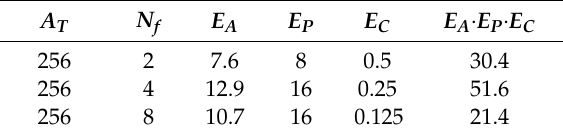
Figure 9. Sensors 2020 , 20 , x FOR PEER REVIEW